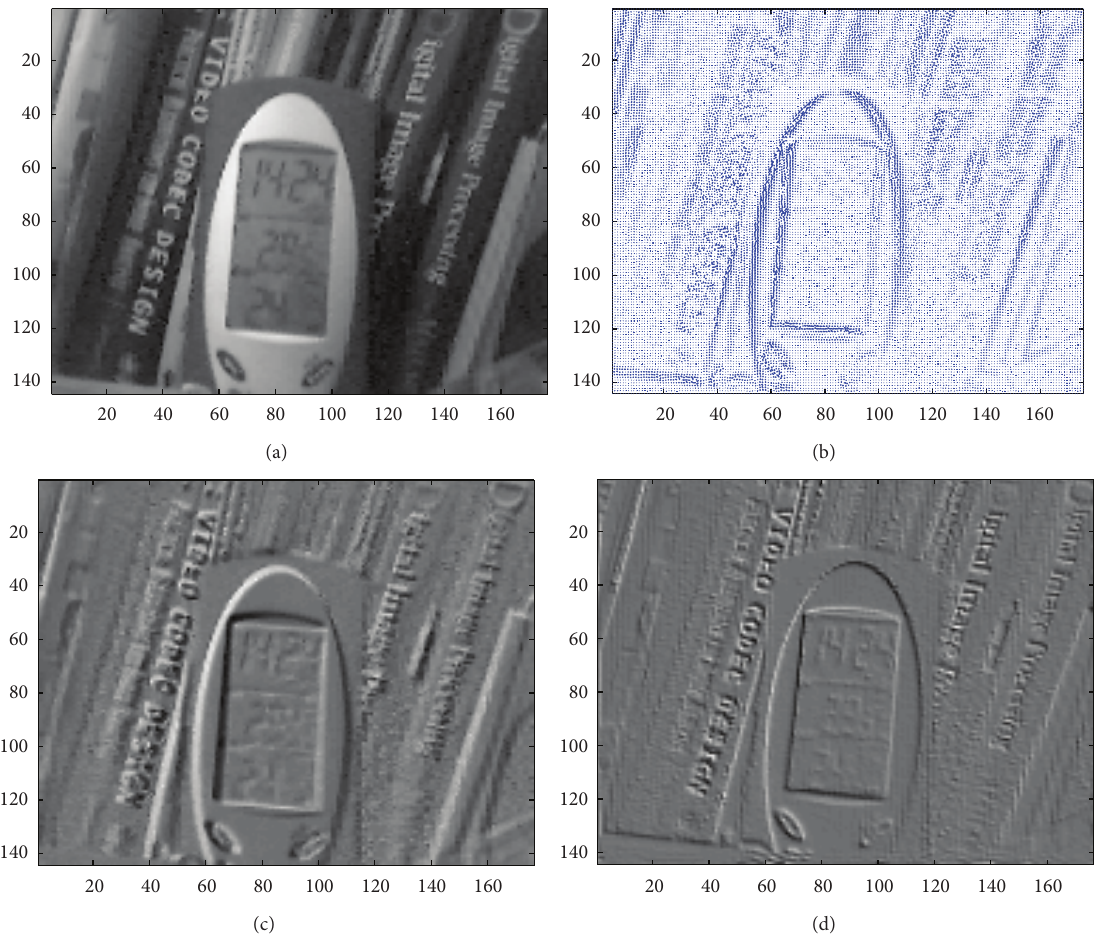
Figure 4: Experimental results from the video sequence “Jerky”: (a) original frame no. 14; (b) dense optical flow field-estimated motion vectors between frames 14 and 15; (c) difference between original frames 14 and 15; (d) difference between stabilized frames 14 and